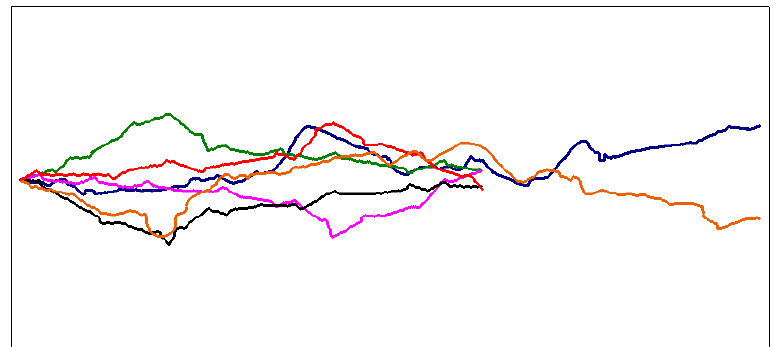
Figure 18. Examples of random profile lines based on the proposed generator vs. real profiles separated out of fracture surfaces of concrete series 2.